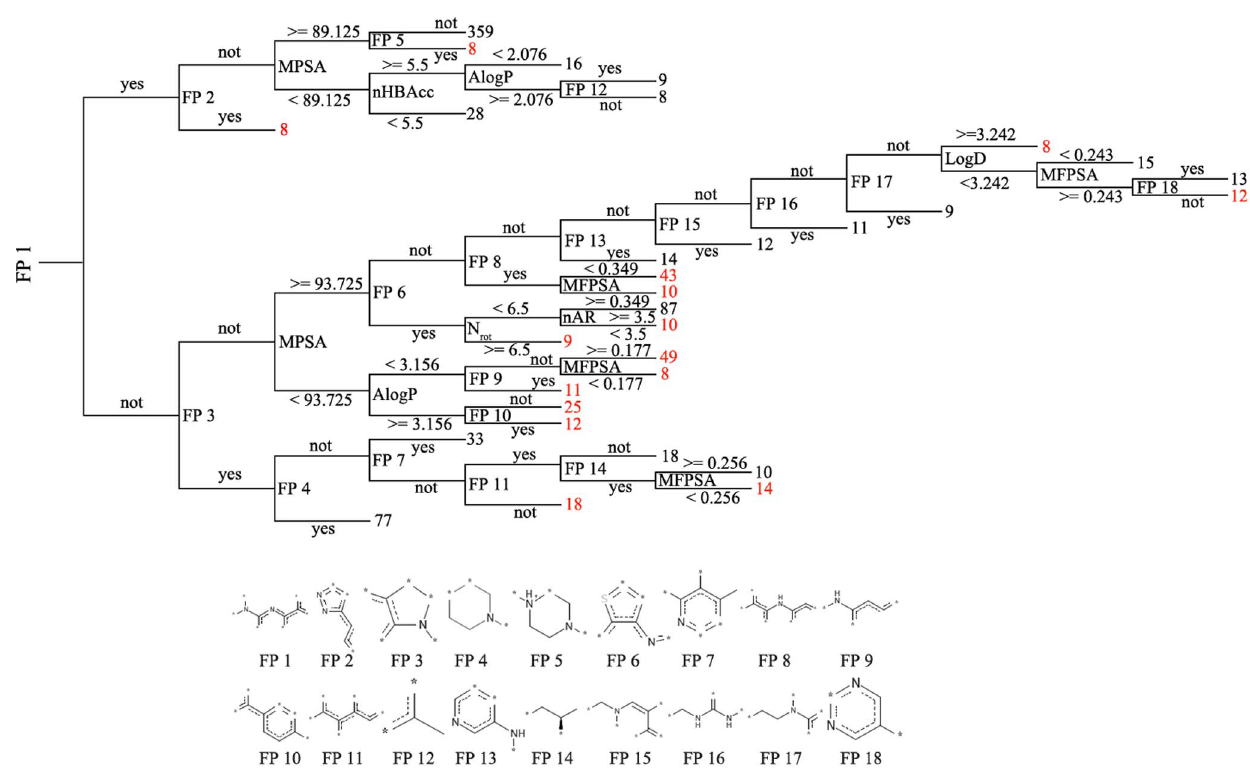
Figure 5. Decision tree to classify compounds into mTOR inhibitor and non-inhibitor classes based on best RP method. The decision tree was constructed using combinational MP and FPFP_4 fingerprint, and the tree depth is 12. FP: Fingerprint; yes: contain this fingerprint; not: not contain; red font represents non-inhibitors; black font represents inhibitors.